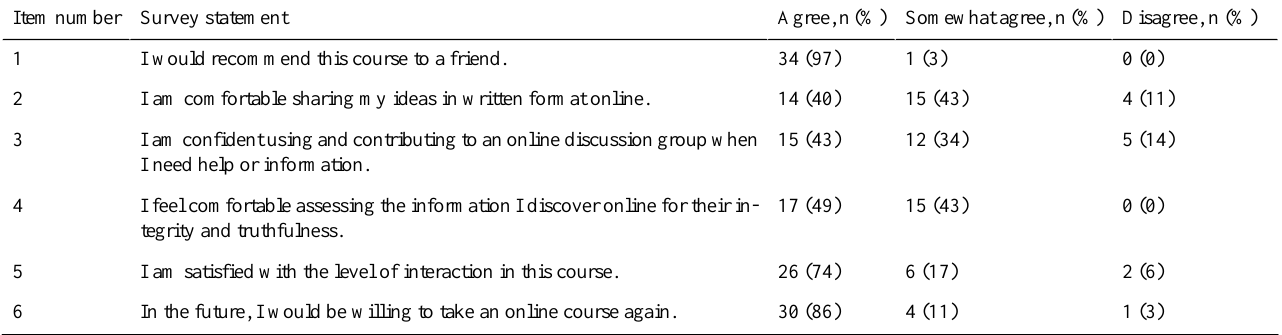
Table 3. Caregiver participant postcourse survey results (n=35).